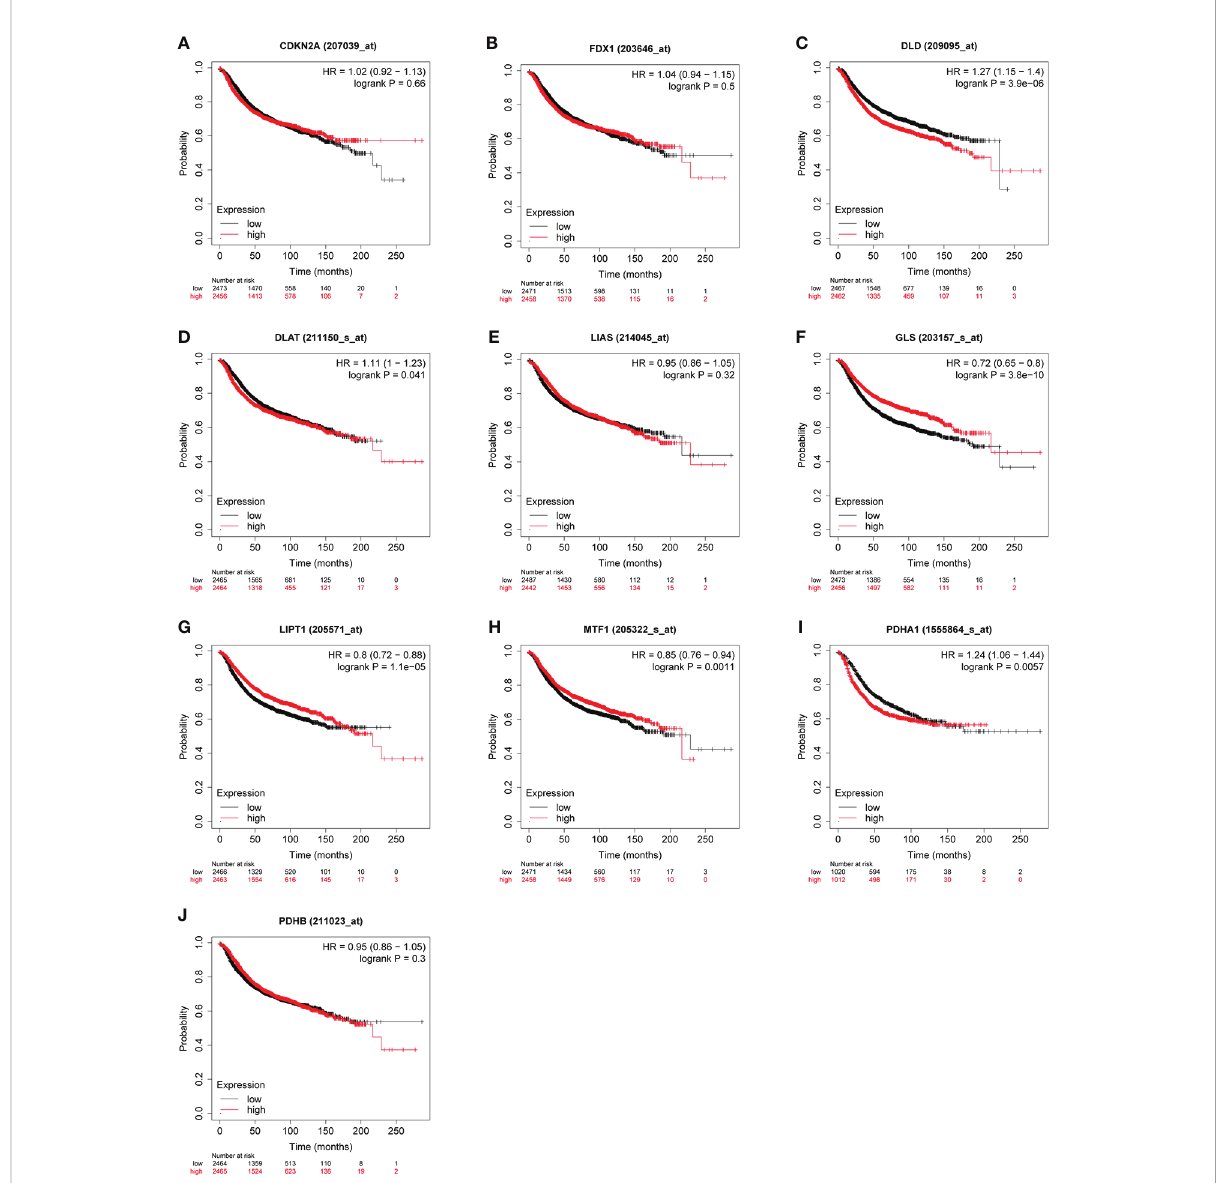
FIGURE 6 Correlation between CRGs (A – J) expression levels and RFS in BC. The curves generated by using the KM plotter database show the prognostic value of